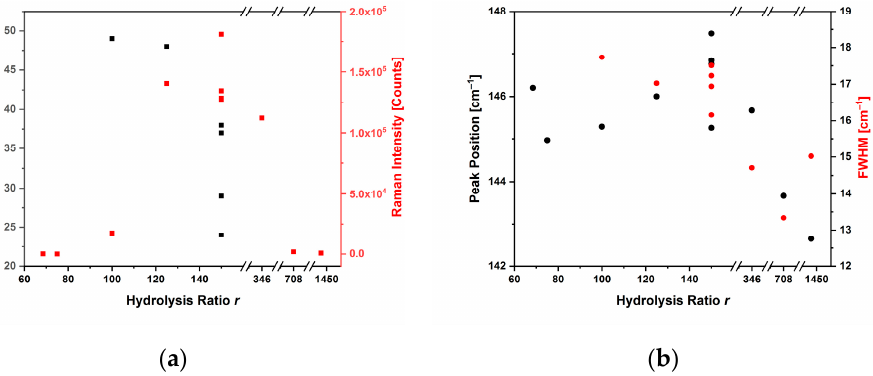
Figure 4. Plots correlating the crystallite diameter and intensity ( a ), position and width ( b ) of the Raman E g(1) peak, with the hydrolysis ratio used in the anatase glycol synthesis.